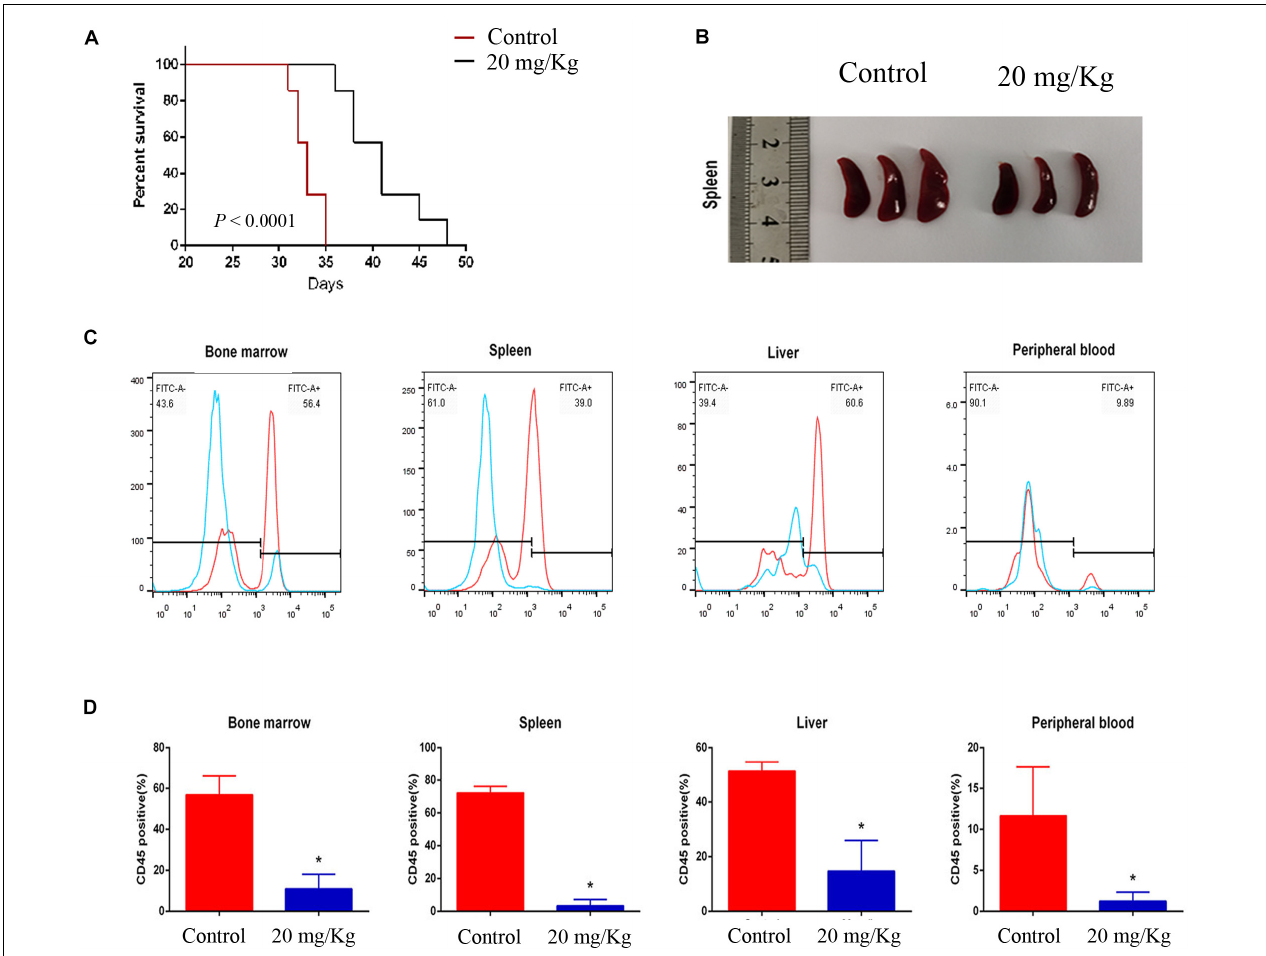
FIGURE 4 | MI-2 impaired leukemia progression in vivo . (A) Kaplan–Meier survival curves for recipient mice transplanted with CCRF leukemic cells are shown. Administration of vehicle or MI-2 (20 mg/kg per day for 20 days) began 2 days after transplantation. (B) Representative photographs of differences in spleen sizes are shown. (C) FACS analysis of the distribution of human CCRF cells in BM, PB, spleen, and liver of mice and stained with anti-human CD45. (D) The percentage of CD45 positive cells was quantified. * P <